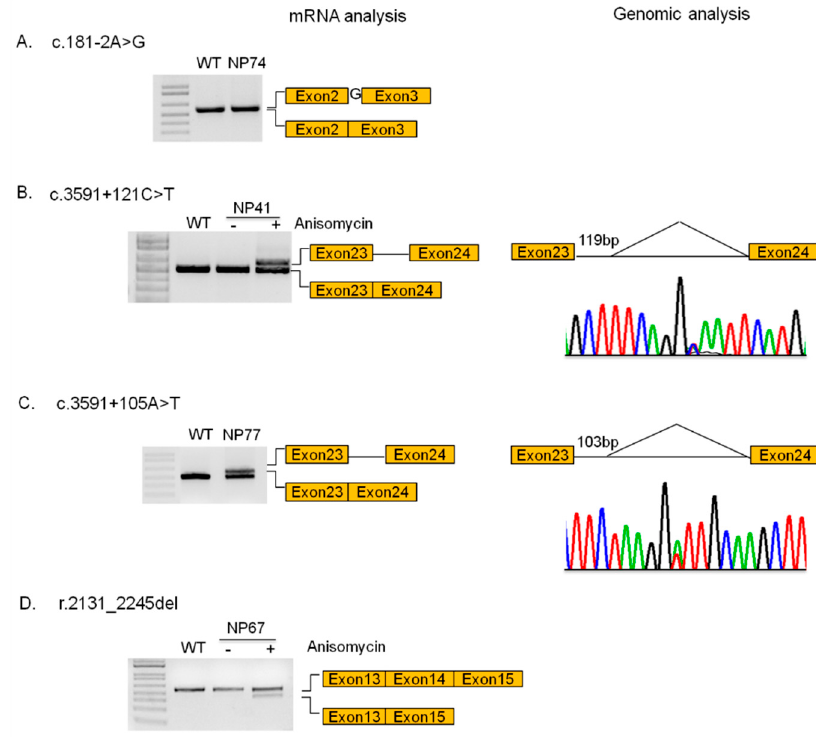
Figure 4. Functional analysis of four NPC1 splicing mutations. ( A ) The c.181-2A > G mutation caused the creation of a novel acceptor splice site leading to the insertion of a nucleotide in the mRNA transcript and the alteration of the reading frame; ( B ) the c.3591 + 121C > T and ( C ) the c.3591 + 105A > T mutations led to the generation of a cryptic acceptor splice site within intron 23, causing the retention of 119 and 103 nt, respectively, the shifting in the open reading frame, and the generation of a premature stop codon. The abnormal transcript resulting from the presence of c.3591 + 121C > T mutation was degraded via non-sense mediated decay (NMD). ( D ) In patient NP67, the skipping of exon 14 was observed (r.2131_2245del). The abnormal transcript was degraded via NMD.